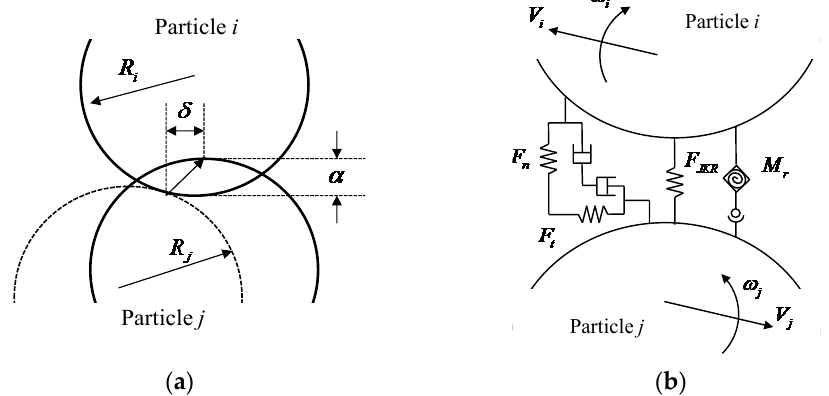
Figure 1. Schematic of the JKR contact model. ( a ) Particle–particle contact model; ( b ) particle–particle force/torque interactions.